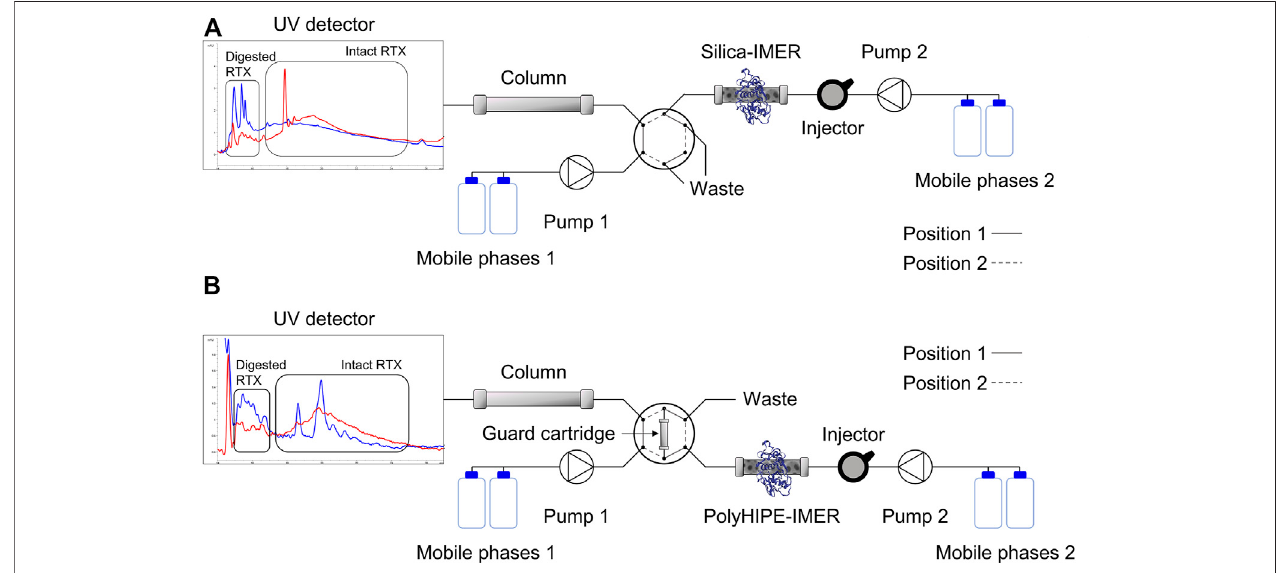
FIGURE1 | On-line system for automated mAb digestionand analysiswith thesilica-IMER (A) and polyHIPE-IMER (B) . ChromatogramsoftheRTX samplebefore (red) and after (blue) incubation in the IMERs are shown. A larger version of the chromatograms is included in the Supplementary Material .